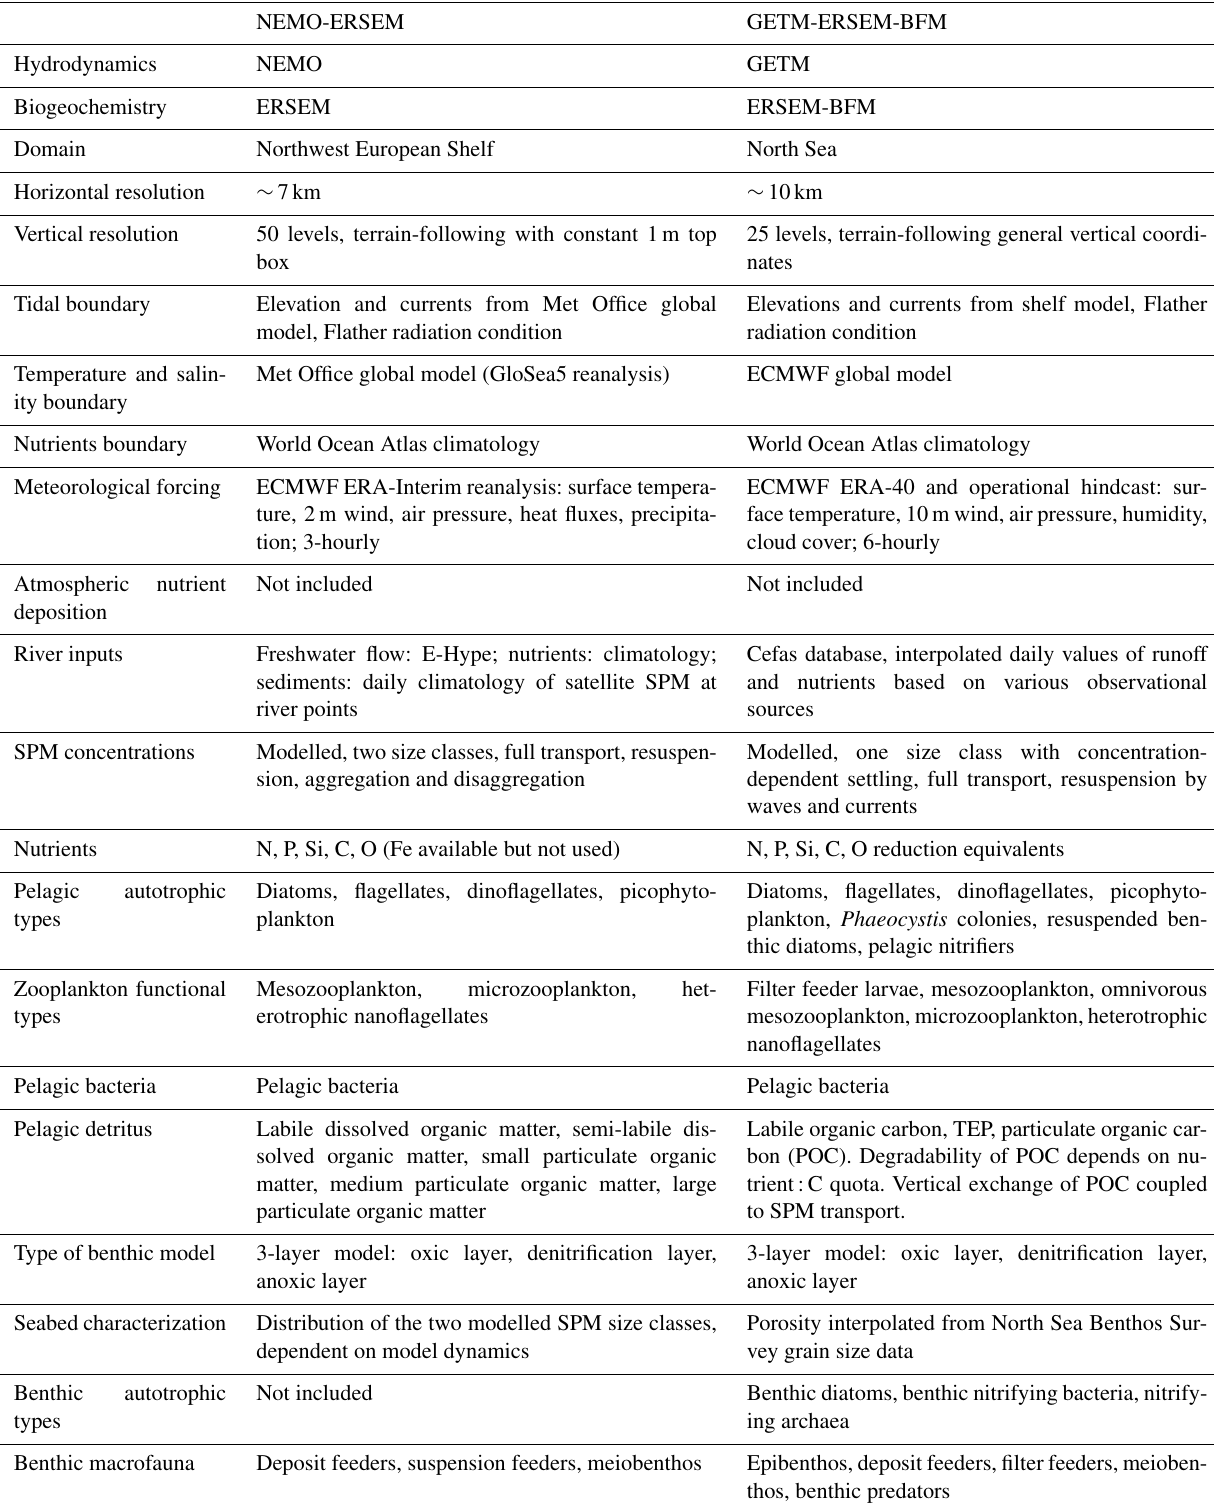
Table 1. Summary of general-level model